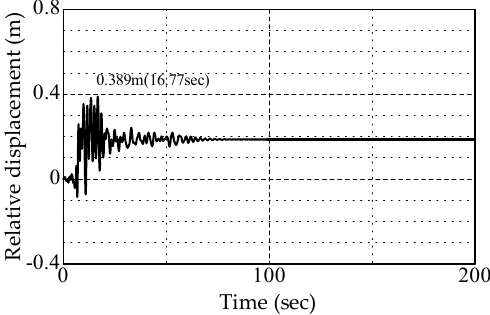
Figure 14. Horizontal displacement in ground surface: seismic motion (B).